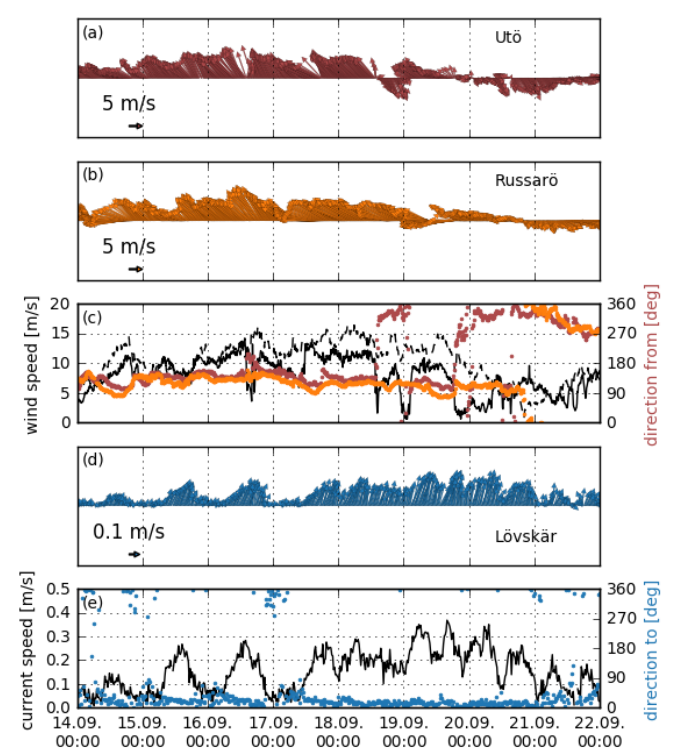
Figure 13. Wind speed and direction at Utö and Russarö AWS ( a – c ), current speed and direction at Lövskär crossing ( d , e ) during 14–22 September 2013. In ( c ), magnitude of Utö winds is marked with solid line and Russarö winds with dashed line. Directions are marked with colours following the practice in upper panels. Locations of the measurement stations shown in Figure